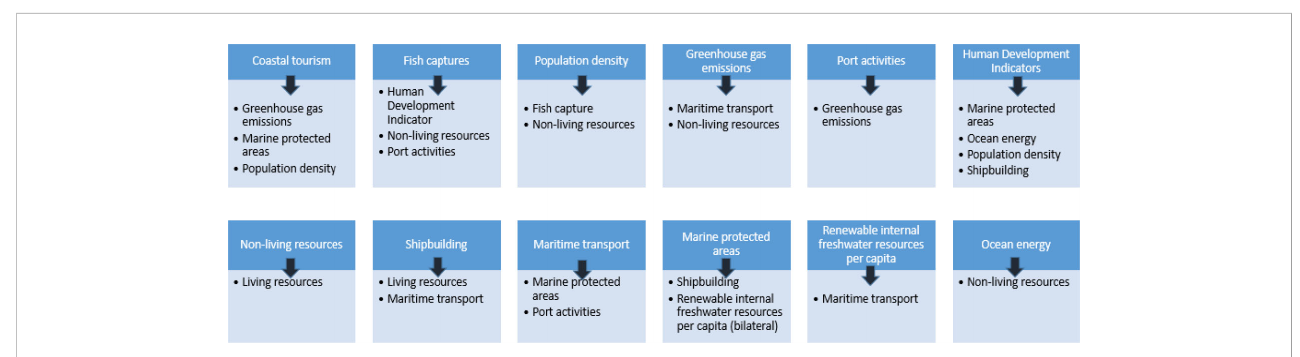
FIGURE 2 Causal relationship among variables (lag length of 2).